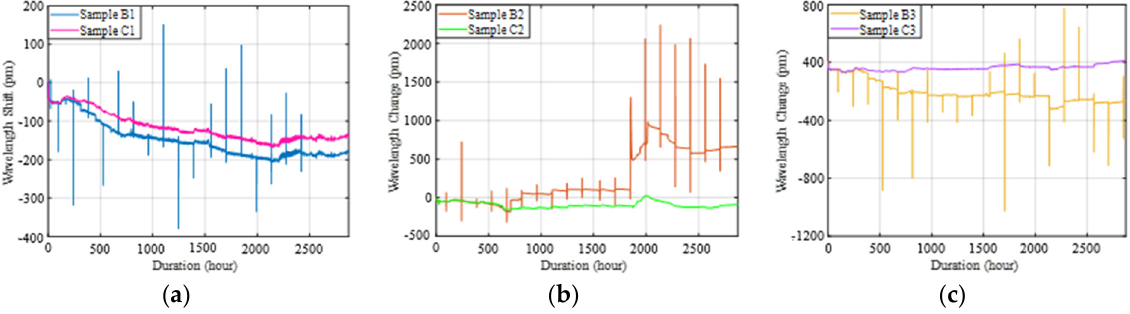
Figure 15. Comparison of recorded Bragg wavelength changes between corrosion-only and combined loading–corrosion tests: ( a ) B1 versus C1, ( b ) B2 versus C2, and ( c ) B3 versus C3. Table 5. Measured average corrosion rates of the tested samples.